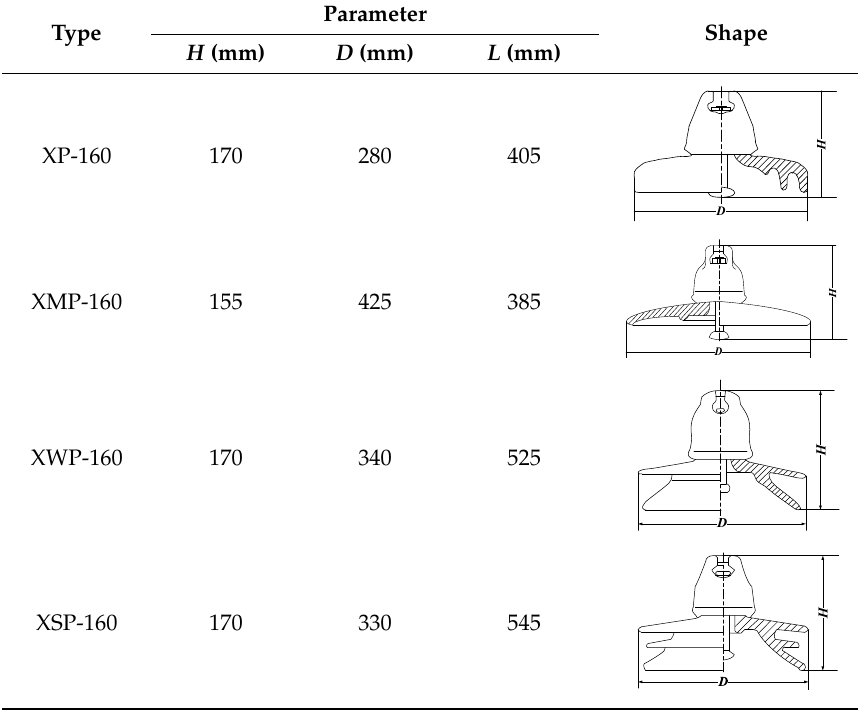
Table 2. Parameter and structure of insulator.